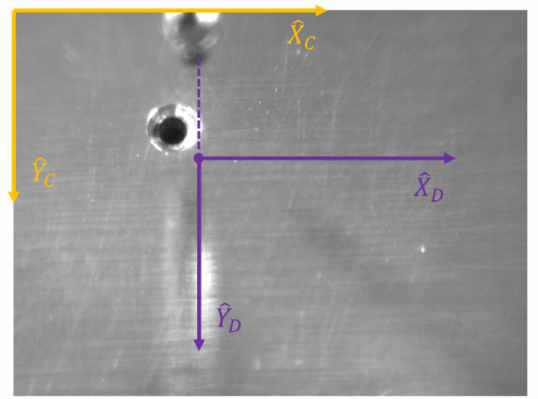
Figure 7. Positions of the coordinate systems { C 2 } and { D }.